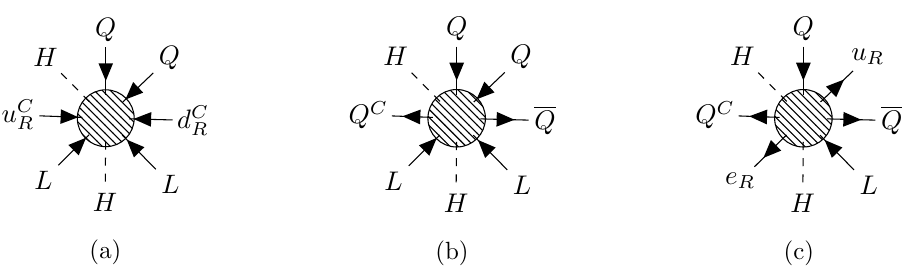
Figure 1 . Diagrammatic representation of the e(cid:11)ective operators O 25 , O 47 , O 55 (from left to right). The arrows on the fermions indicate the chirality with the convention being that the arrow points in for left-handed